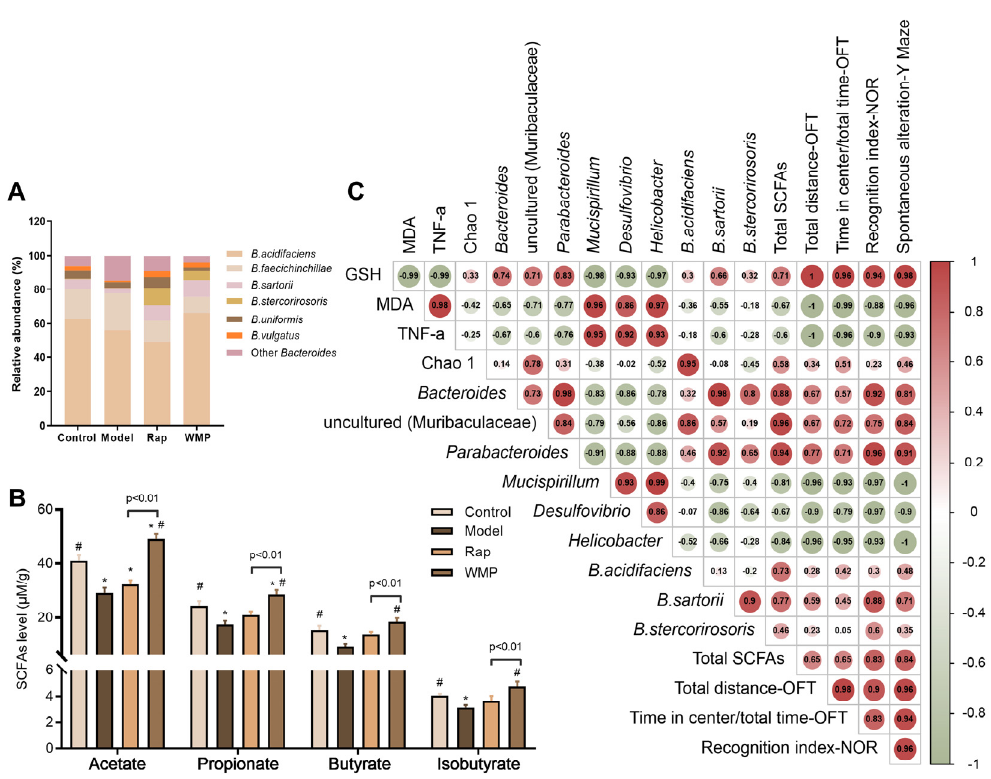
Figure 6. Effects of WMP on the SCFAs level and the Spearman correlation analysis. ( A ) Effects of WMP on the Bacteroides , ( B ) The SCFAs levels, and ( C ) the Spearman correlation analysis. The colors and values indicate the distribution of the Spearman’s correlation coefficients. * p < 0.05 vs control group and # p < 0.05 vs model